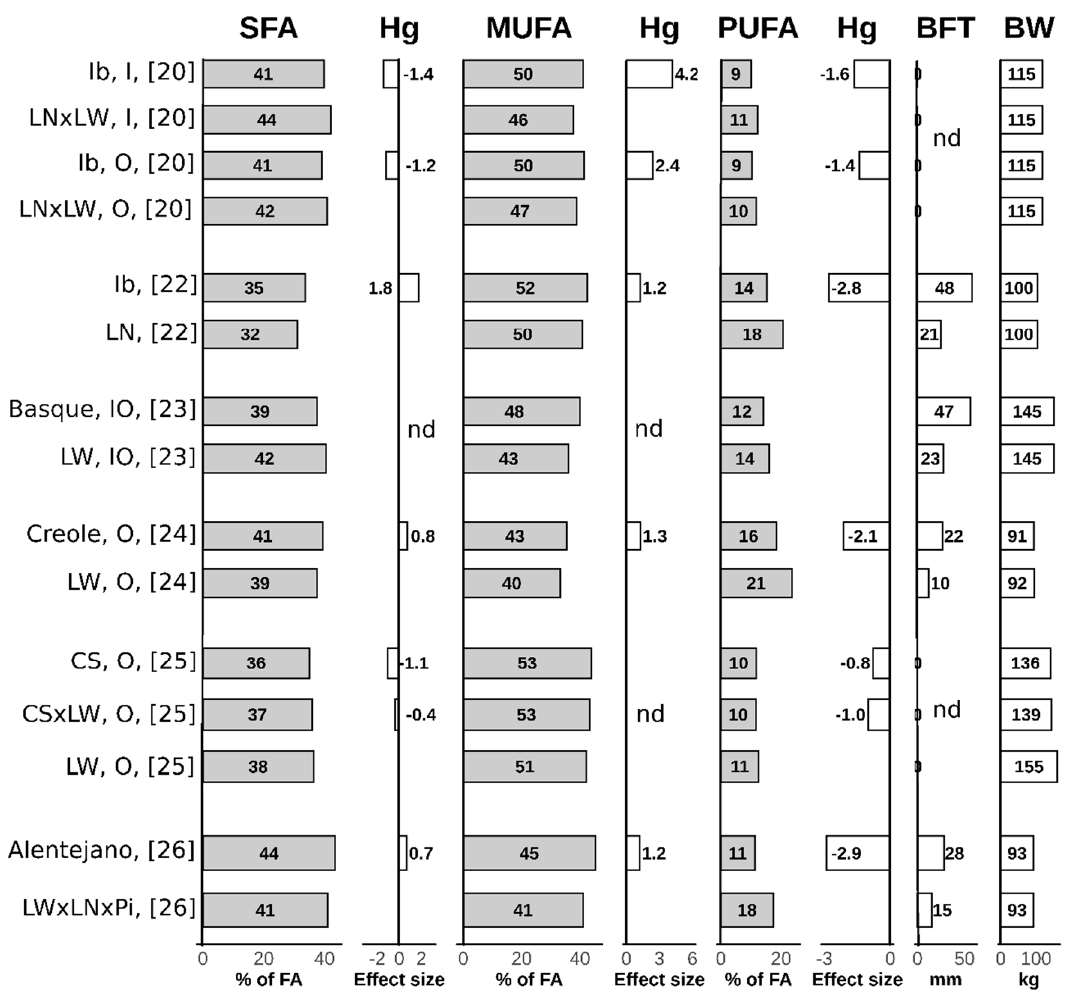
Figure 1. Fatty acid composition of subcutaneous adipose tissue of local vs. modern pig breeds and within-study effect size (Hedges’ g) [27]. Studies were carried out in different conditions (including body weight, backfat thickness) and should be interpreted accordingly. Effect size (Hedges’g) [27] is considered to be medium if it is above 0.5 or below − 0.5 and large if it is above 0.8 or below − 0.8. In the case of Reference [20], the effect size for the inner and outer backfat layer was calculated separately. SFA = saturated fatty acids; MUFA = monounsaturated fatty acids; PUFA = polyunsaturated fatty acids; Hg = Hedges’ g; BFT = backfat thickness; BW = body weight; I = inner back fat layer; O = outer back fat layer; FA = fatty acids composition; Ib = Iberian pig breed, LN = Landrace; LW = Large White; Pi = Piétrain; CS = Cinta Senese; nd = calculation of Hedges’g was not possible due to missing data.